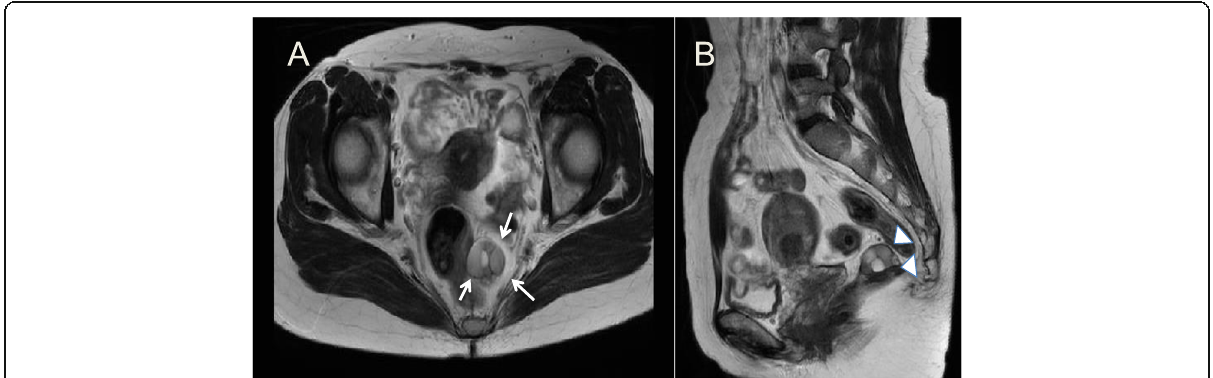
Fig. 3 Magnetic resonance imaging. a On T2-weighted coronal magnetic resonance imaging, it appears that the 30-mm multicystic tumor on the left side of the posterior rectum is strongly adhered to the rectal wall (white arrow). b The enhancing cystic portions (white area in the center of the tumor) are accompanied by solid components (gray area at the margin of the tumor) (white arrowhead)